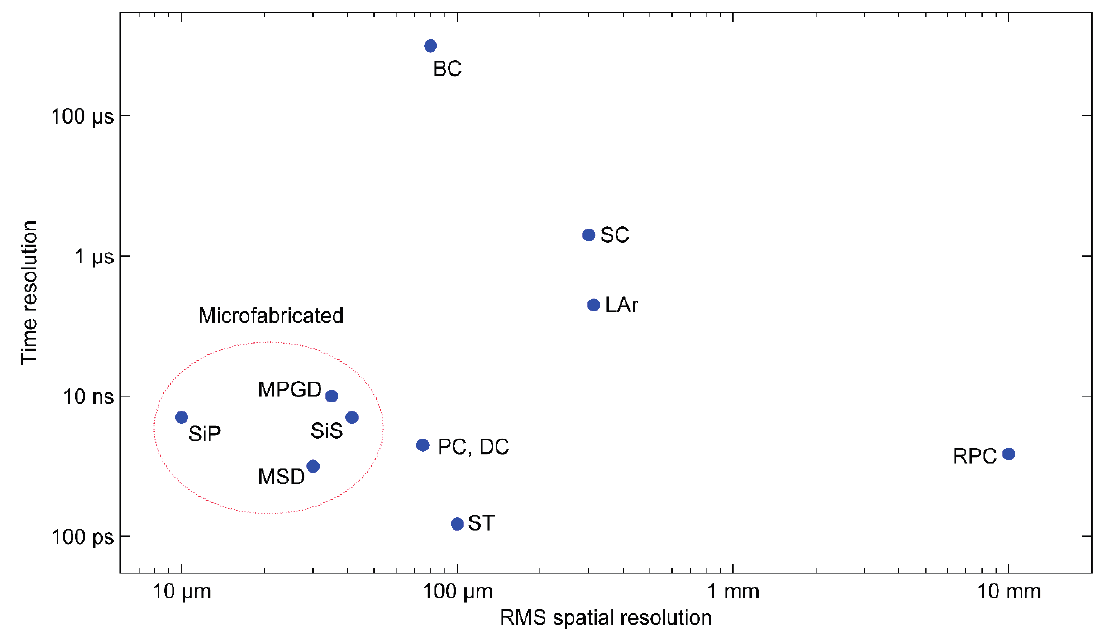
Figure 1. Typical spatial and time resolutions for several particle detector technologies: resistive plate chambers (RPC), streamer chambers (SC), liquid argon drift (LAr), scintillation trackers (ST), bubble chambers (BC), proportional chambers (PC), drift chambers (DC), micropattern gas detectors (MPGD), silicon strips (SiS), silicon pixels (SiP), microfluidic scintillation detectors (MSD). All data from [1] (Table 31.1) except for